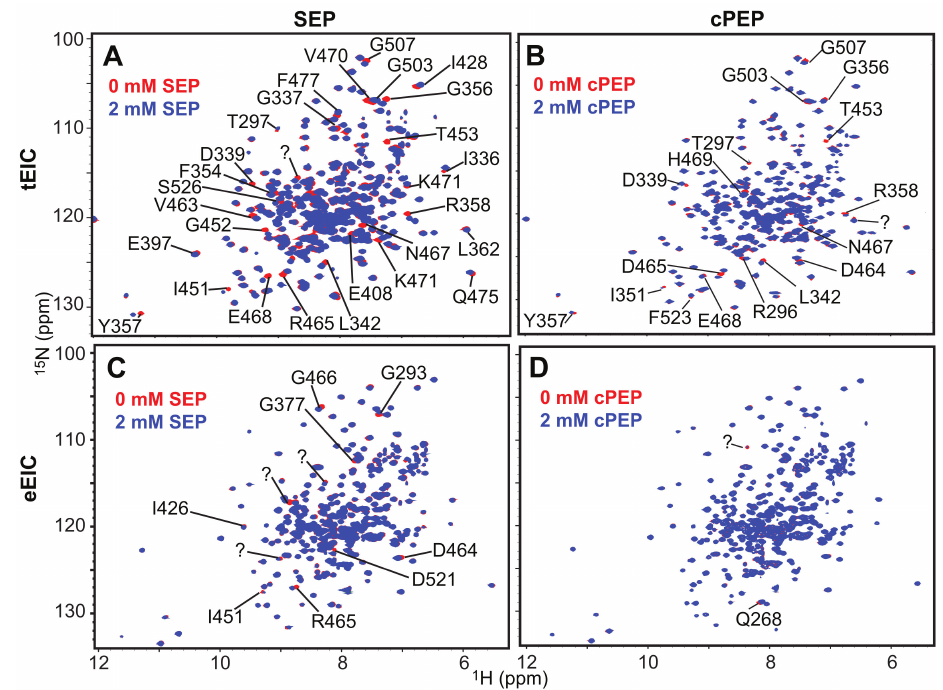
Figure 2. 800 MHz 1 H- 15 N TROSY spectra of tEIC and eEIC measured in the absence (red) and in the presence (blue) of 2 mM SEP or cPEP. Panels ( A – D ) display the data measured for the tEIC–SEP, tEIC–cPEP, eEIC–SEP, and eEIC–cPEP systems, respectively. Peaks that shift upon addition of ligand are assigned in the spectra. “?” indicates peaks with unknown assignment.